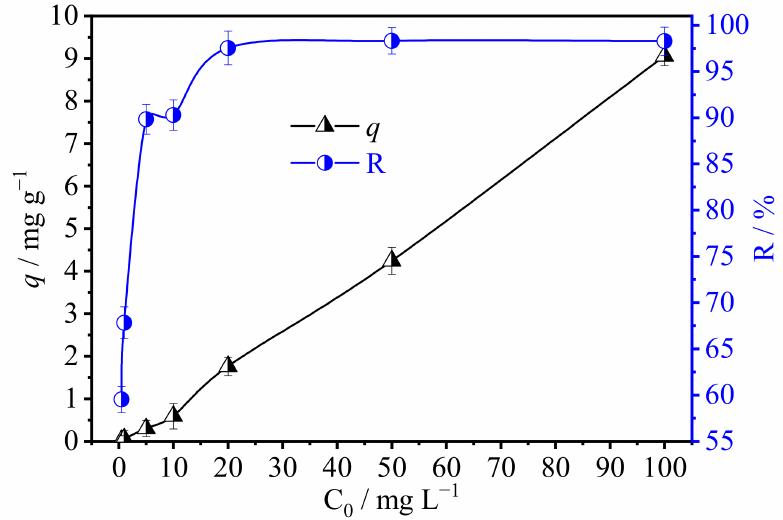
Figure 8. Effect of initial concentration of U(VI) by SAIEF (t = 30 min, m =1 g, pH =